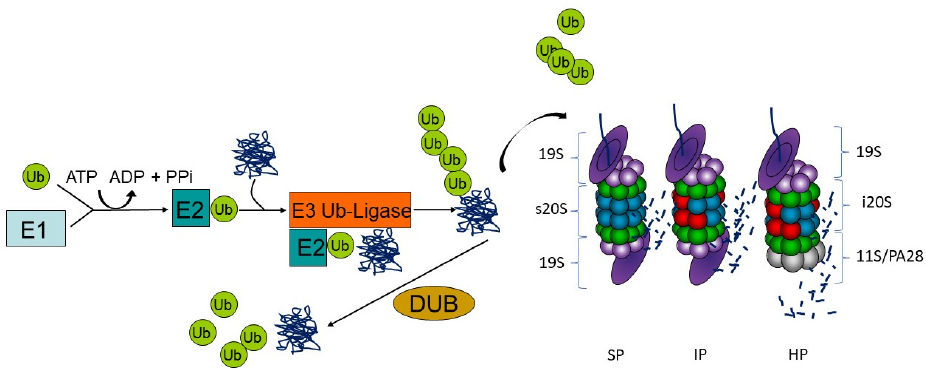
Figure 1. Protein substrates are covalently modified with ubiquitin by the thioester cascade. The ubiquitin-activating enzyme E1 that activates ubiquitin (Ub, green circle) under ATP-hydrolysis to form a thioester bond and transfers the activated ubiquitin to an E2 ubiquitin-conjugating enzyme. The E2 enzyme in turn interacts with its cognate E3 ubiquitin ligase to transfer the ubiquitin moiety covalently on a protein substrate. This thioester cascade has to run several times to form ubiquitin chains. Deubiquitinating enzymes (DUBs) can counteract this process to control protein degradation and recycle ubiquitin. Protein substrates modified by lysine 48 (K48)-linked ubiquitin chains are marked for degradation by different proteasome isoforms, such as standard proteasomes, immuno- proteasomes or hybrid proteasomes. Immunoproteasomes contain alternative active sites, which are induced by immune signaling, whereas hybrid proteasomes additionally contain an alternative regulator complex (11S/PA28) on one site of the 20S core complex. These isoforms are thought to confer improved degradation capacities.